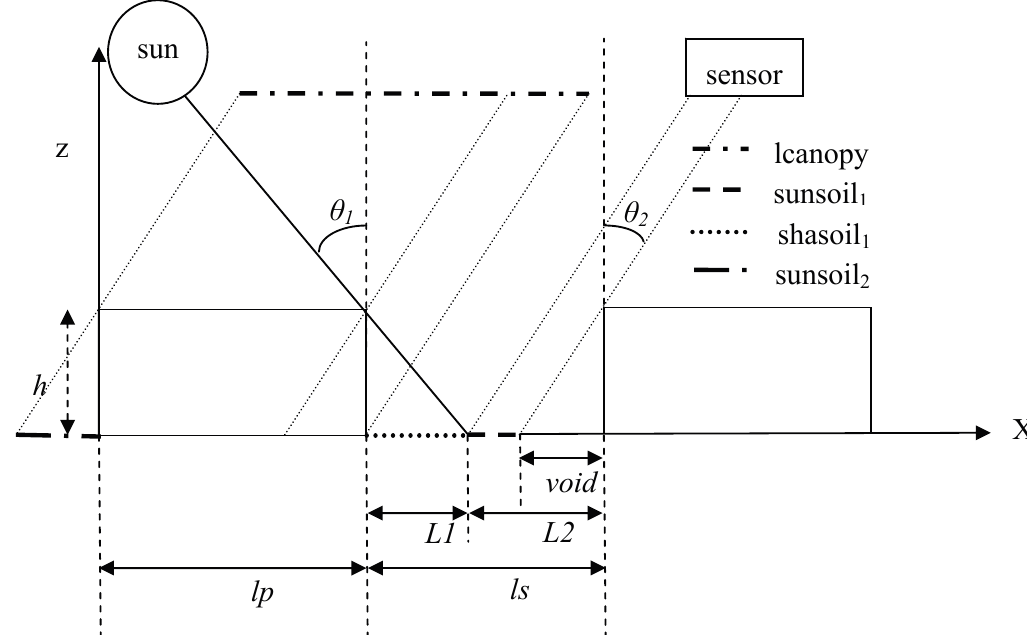
Figure 4. Sketch map of the backward-scatter